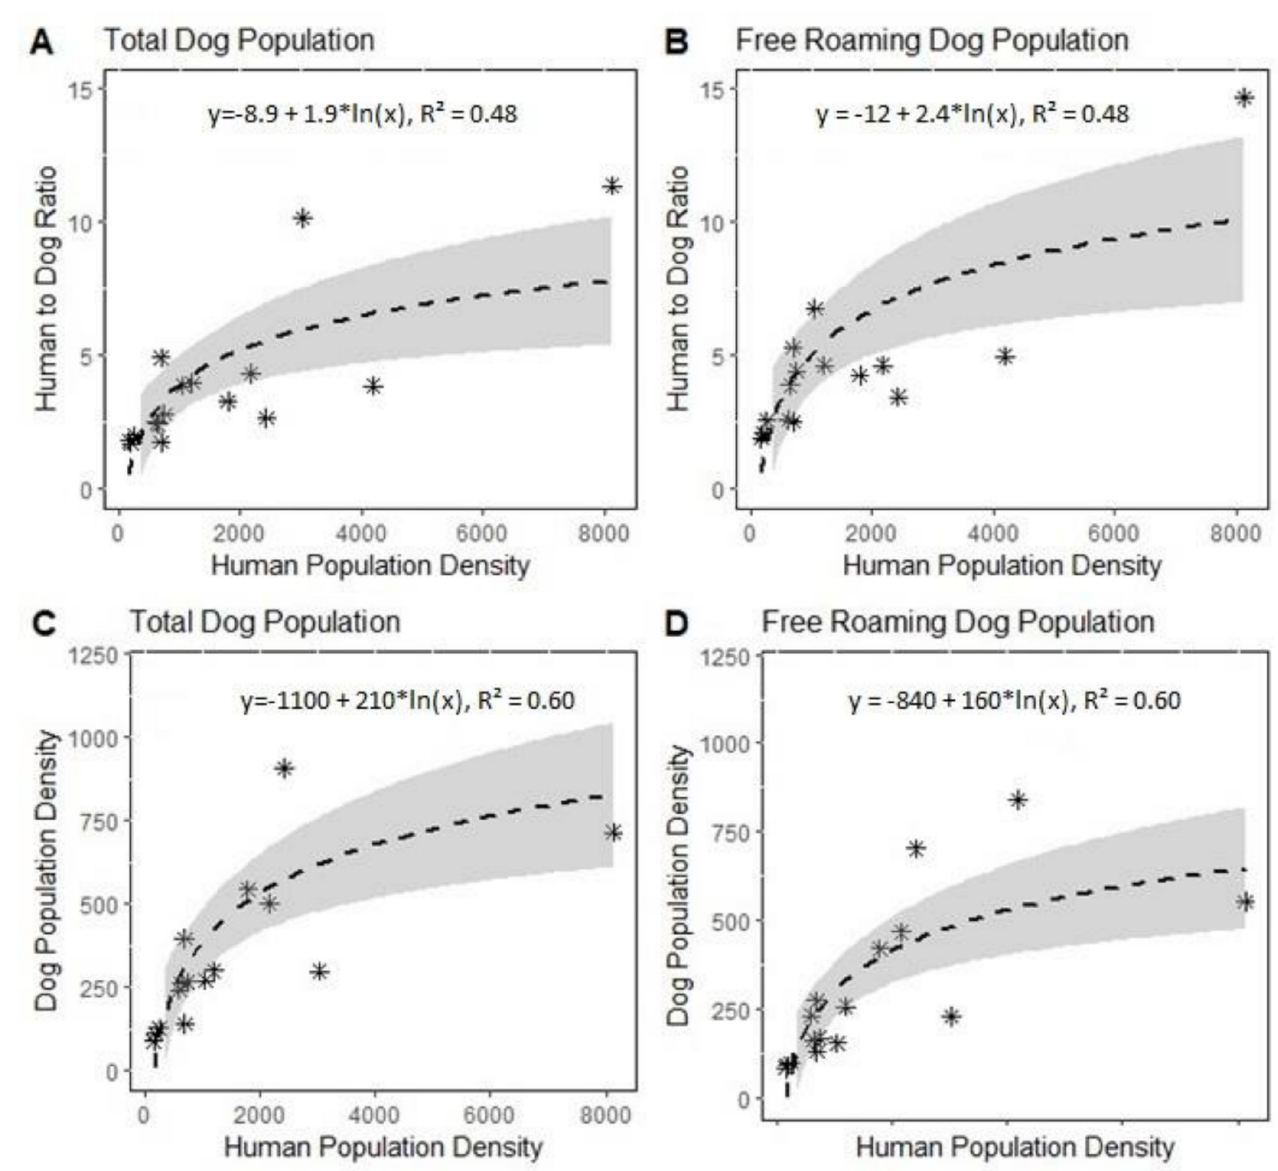
Fig 6. Association between the free roaming dog population density and the human population density amongst the study sites, March—July 2018.